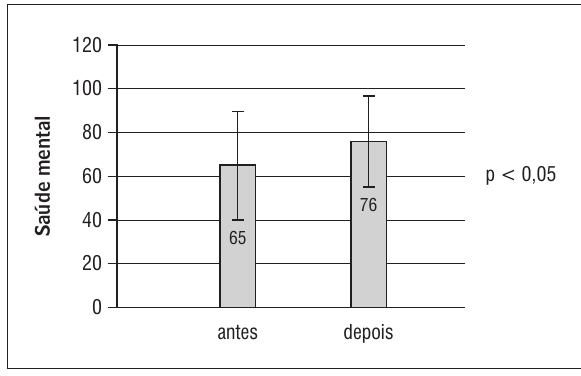
Figura 8 - Média e desvio-padrão da saúde mental dos pa- cientes antes e depois do protocolo fisioterapêu- tico (n = 27; p <